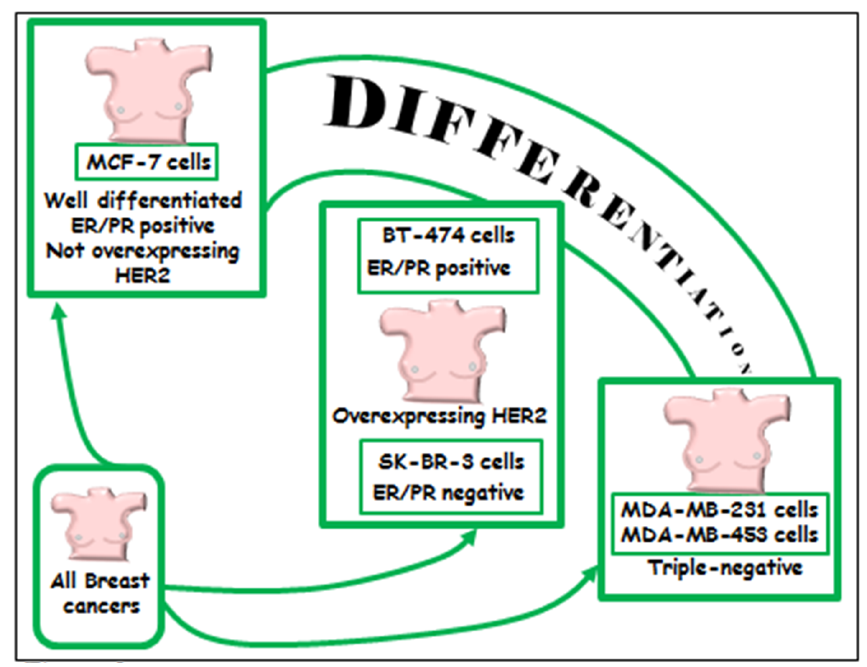
Figure 2. Outline of the breast cancer cell lines used in most of the in vitro studies analyzed, and their main features. MCF7 cells are the most differentiated and represent the most used in vitro model for well-differentiated breast cancer, since they express Estrogen Receptors (ER), and/or Progesteron Receptors (PR). Both ER/PR positive BT-474 and ER/PR negative SK-BR-3 cells are scarcely differentiated cells and share the overexpression of the receptor tyrosine kinase HER2 codified by the oncogene ErbB2. They represent in vitro models for HER2 positive breast cancer. MDA-MB-231 and MDA-MB-453 cells are the least differentiated, and represent in vitro models for triple negative breast cancers, i.e., they do not express ER/PR receptors or overexpress HER.